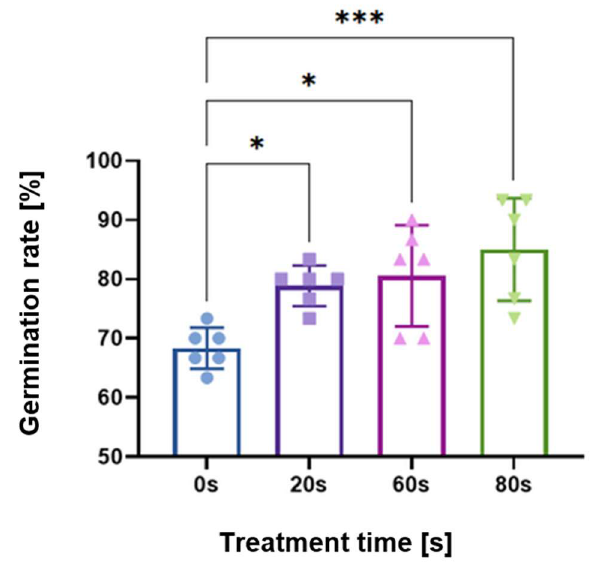
Figure 1. Germination rate results of plasma-treated Arabidopsis thaliana (L.) Heynh. seeds, demon- strating that 80 s had the strongest effect followed by the 60 s treatment. Control experiments, i.e., no plasma treatment, are indicated with 0 s. Shown as an average of triplicates performed twice independently for a total of 6 replicates. Asterisks denote statistical significance where * signifies p < 0.05; ** is p < 0.01; and *** is p < 0.001.